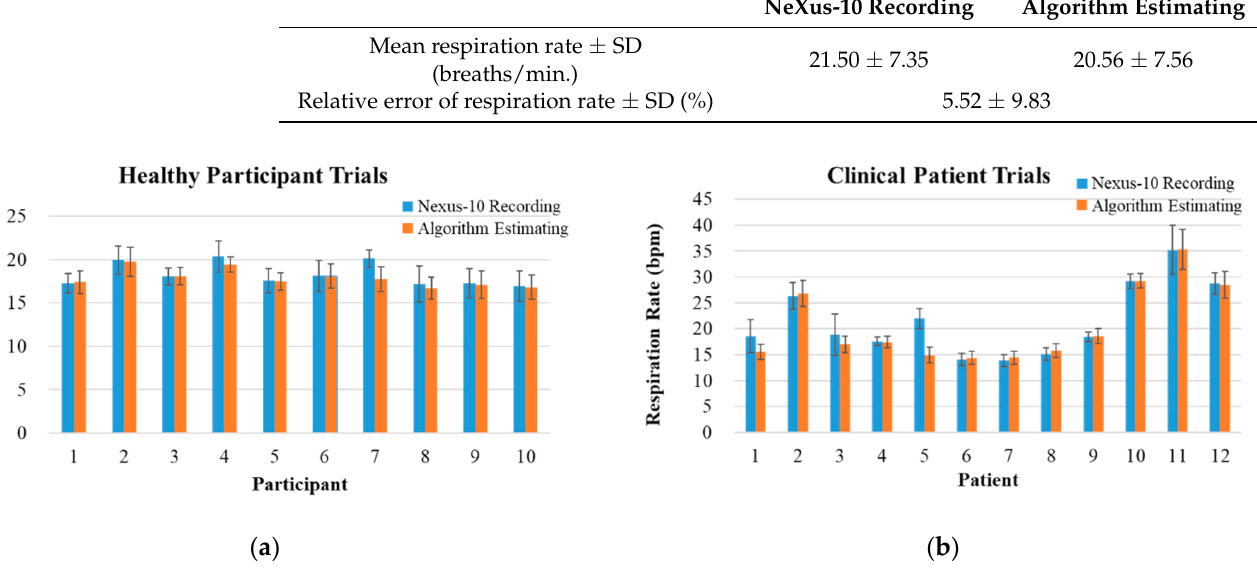
Figure 8. NeXus-10 recording and algorithm estimating values of ( a ) healthy participant and ( b ) clinical patient trials for the ECG-derived respiration algorithm. The measurement of RR is represented in breaths per minute (bpm). Table 3. ECG-derived respiration algorithm results (healthy participant).